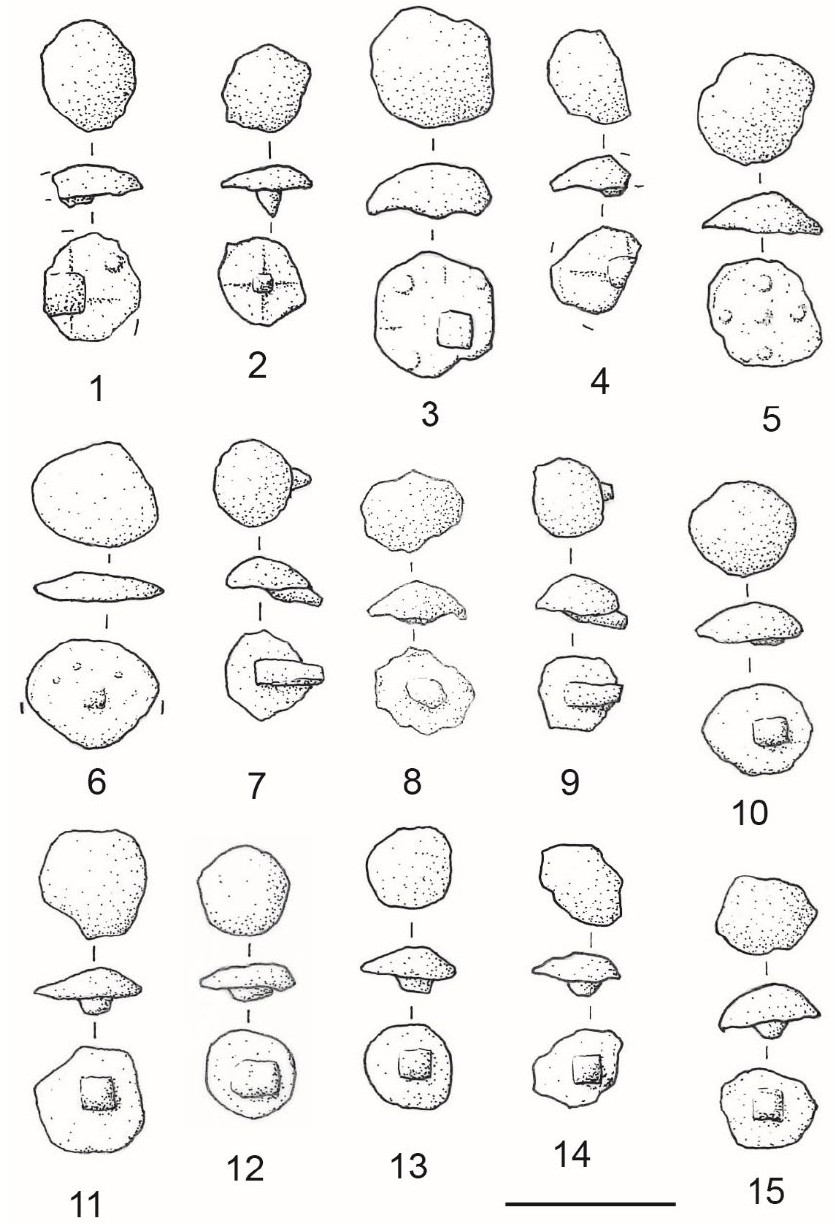
Figure 13. Roman shoe hobnails from area G. Scale bar: 2 cm; drawings by A. Fragiacomo.